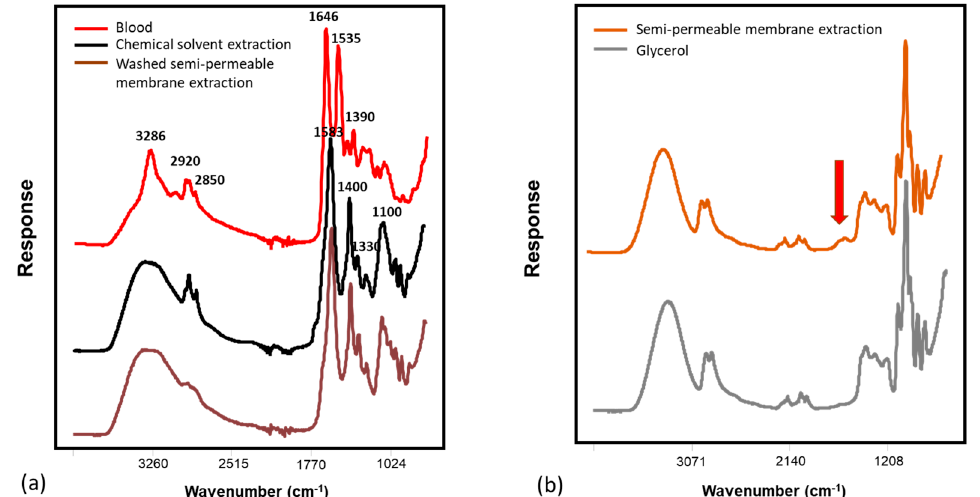
Figure 3. FT-IR representative spectra of ( a ) blood aliquot, plasma extracted by a chemical solvent precipitation method and low-molecular-weight fraction (LMF) of human blood obtained by a washed semi-permeable membrane extraction method, and ( b ) glycerol and plasma extracted by a non-washed semi-permeable membrane extraction approach, collected by a portable 3-reflection ATR system (4500a series); The red arrow marked the main spectral difference.